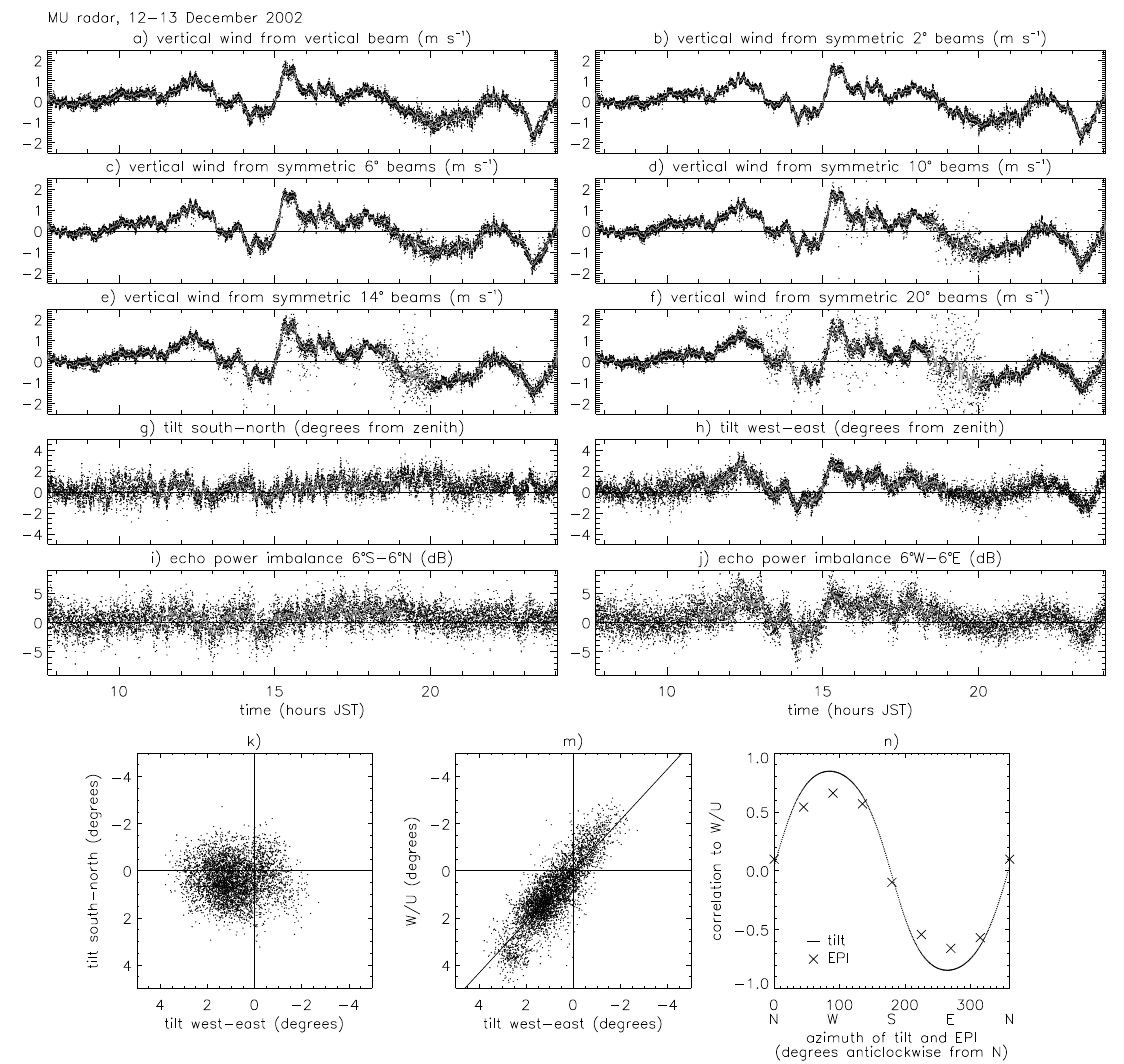
Fig. 5. (a–f ) Vertical wind measured by 0 ◦ , 2 ◦ , 6 ◦ , 10 ◦ , 14 ◦ and 20 ◦ beams; ( g, h ) tilt of aspect-sensitive echo power; ( i, j ) EPI between symmetric beams. (a–j) are averaged 2–4km AGL where mountain waves are nearly constant with height in Figs. 2c and d. Measuring time of each dot is 6.55s, and a 5-min running mean is overplotted; ( k ) scatterplot of tilts (g, h); ( m ) scatterplot of zonal tilt of air flow and aspect-sensitive echo; ( n ) correlation of 6 ◦ EPI and aspect-sensitive tilt, as a function of azimuth, to zonal tilt of airflow. (k–n) are for 11–19 JST, when there is aspect-sensitive tilt and